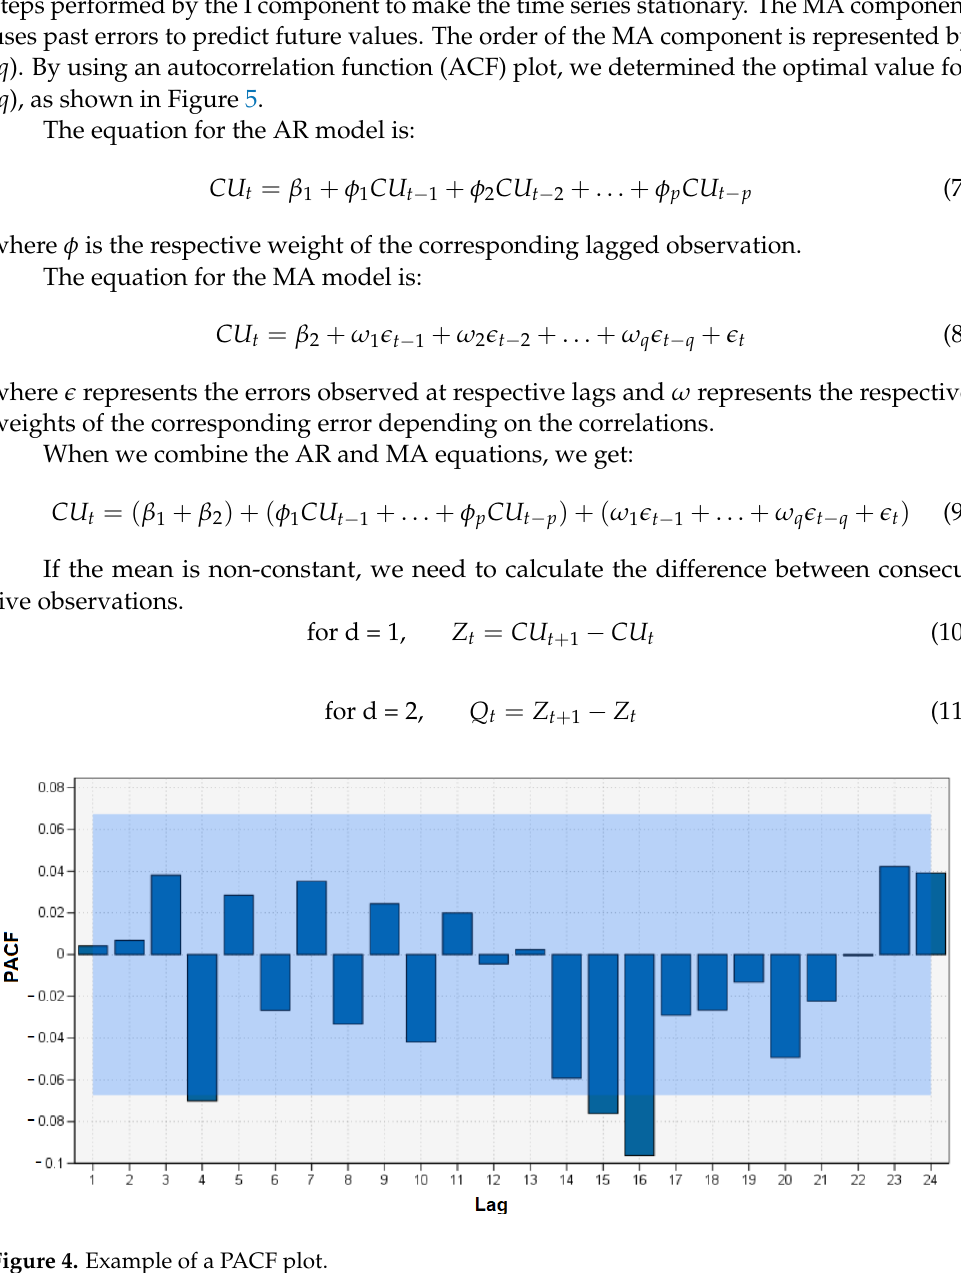
Figure 4. Example of a PACF